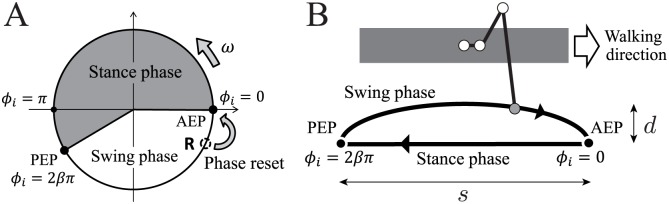
Leg movement based on oscillator phase.A: Oscillator phase. B: Desired leg movement. AEP and PEP represent the anterior extreme position and the posterior extreme position, respectively.